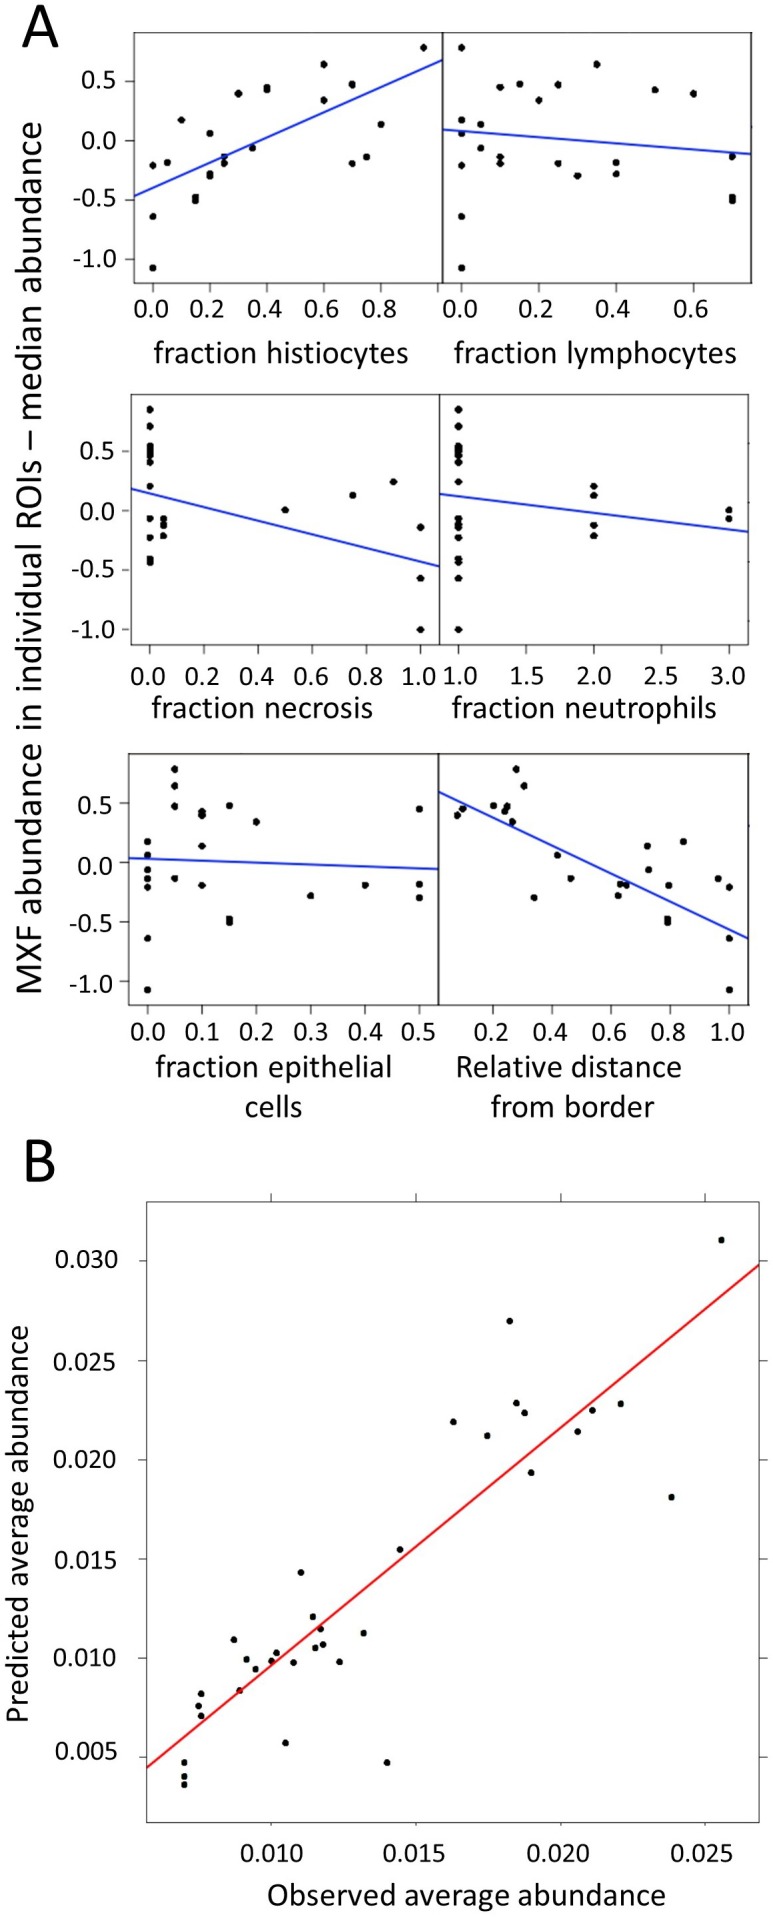
Modeling of MXF abundance as a function of histology parameters (raw data can be found in Figure 4—source data 1).(A) Diagnostic plots of Empirical Bayes Estimates (EBEs) supporting the covariate search and showing MXF abundance differences to the median (Y axes) as a function of each of the six candidate predictors, as indicated. The blue line indicates the correlation trend: positive for % histiocytes, negative for % necrosis and relative distance to lesion border, and neutral for the other predictors, thus illustrating the biological relationship between drug abundance and % histocyte as well as distance from the border; (B) Visual Predictive Checks (VPC) showing model-predicted MXF abundance versus observed abundance, indicating that drug abundance can reliably be predicted based on macrophage content, relative distance from granuloma border, and necrosis content, according the model equation: MXFabundance=θ1×eθ2×(Histiocytes%-0.35)×eθ3×(DistanceRatio-0.65)×(1+θNecrosis).10.7554/eLife.41115.015Figure 4—source data 1.nonMEM model codes of base and final models.